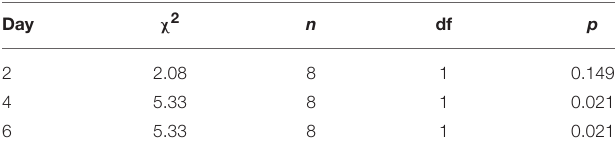
TABLE 1 | Statistical summary comparing differences in the Microcystis to Cryptomonas biomass ratio (M:C) among controls (no-grazers) and treatments (with-grazers) for each experimental day in the facilitation experiment as evaluated by Kruskal-Wallis tests.